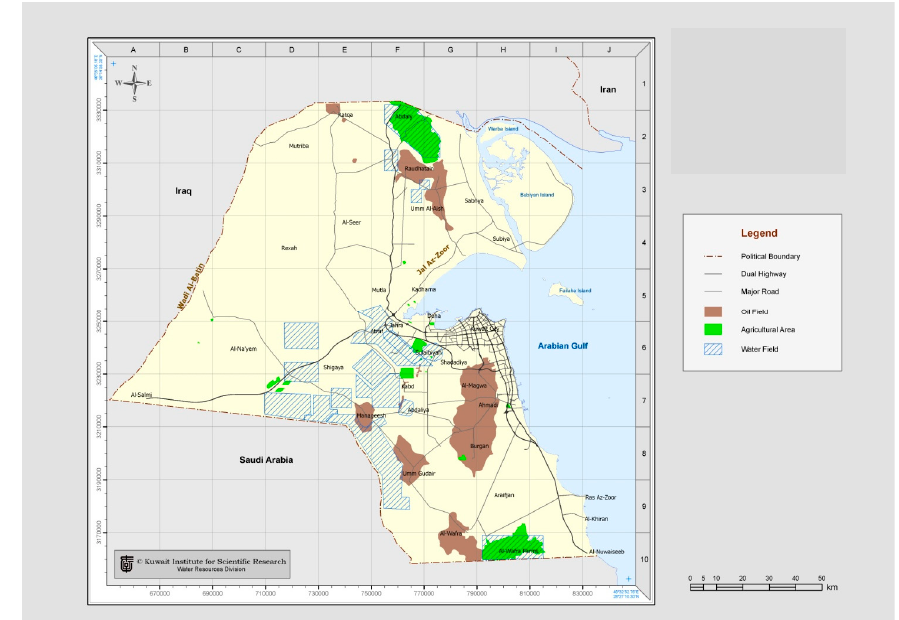
Figure 1. Location of the state of Kuwait and established groundwater wellfields (Source [10]